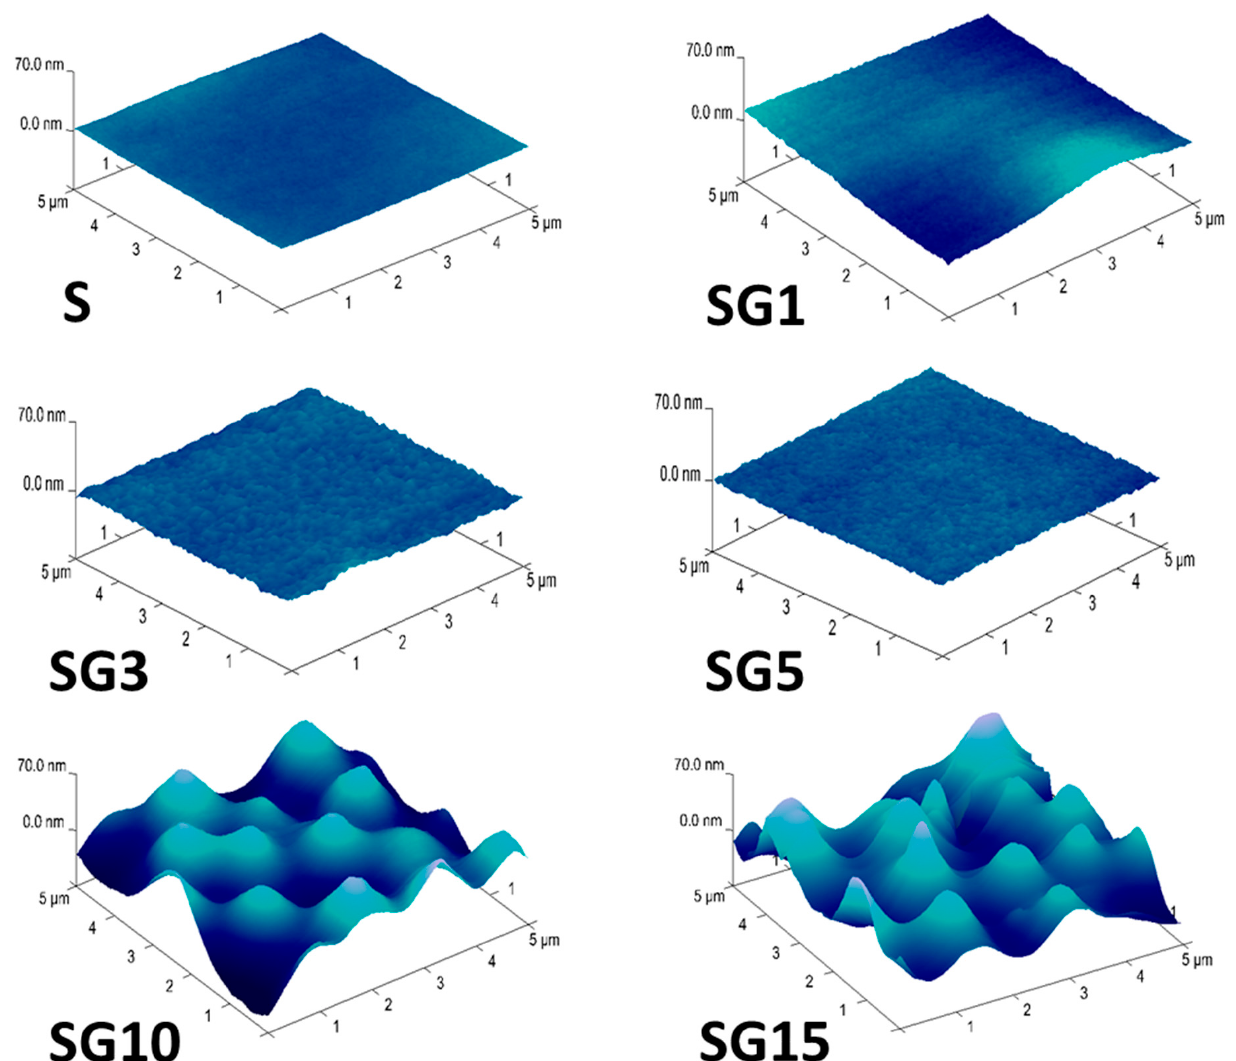
Figure 8. Atomic Force Microscope (AFM) images of pure Sylgard and its composites containing